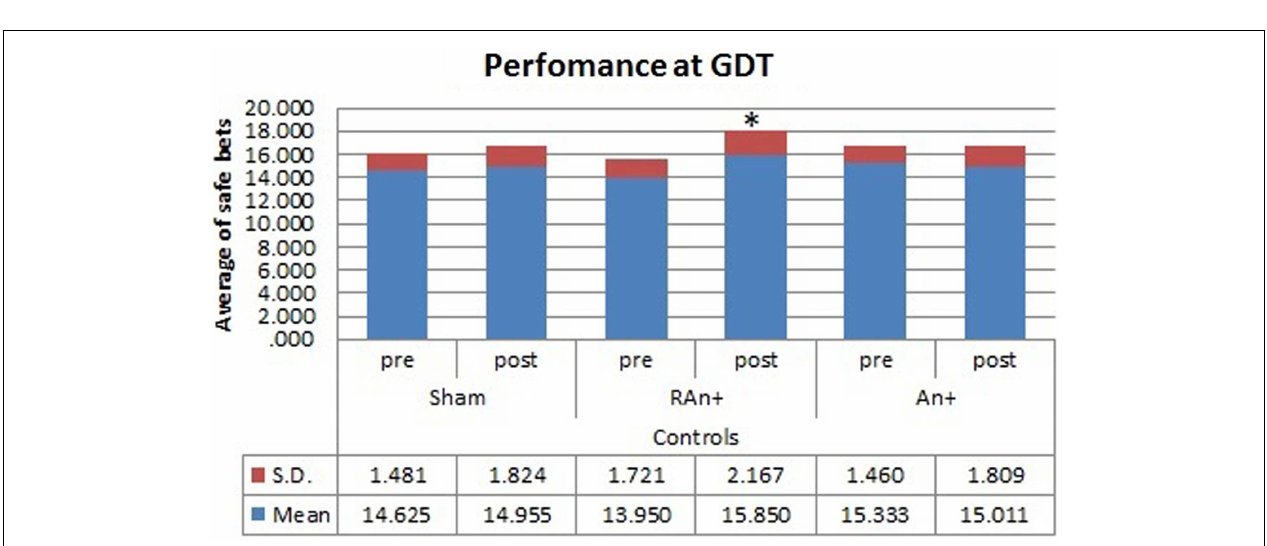
FIGURE 6 | Controls’ performance at the GDT test .This figure represents the controls’ performance (average of safe bets) at the GDT test before and after each stimulation. Safe bets are defined as choices in line 3 and 4 (* p < 0.05).